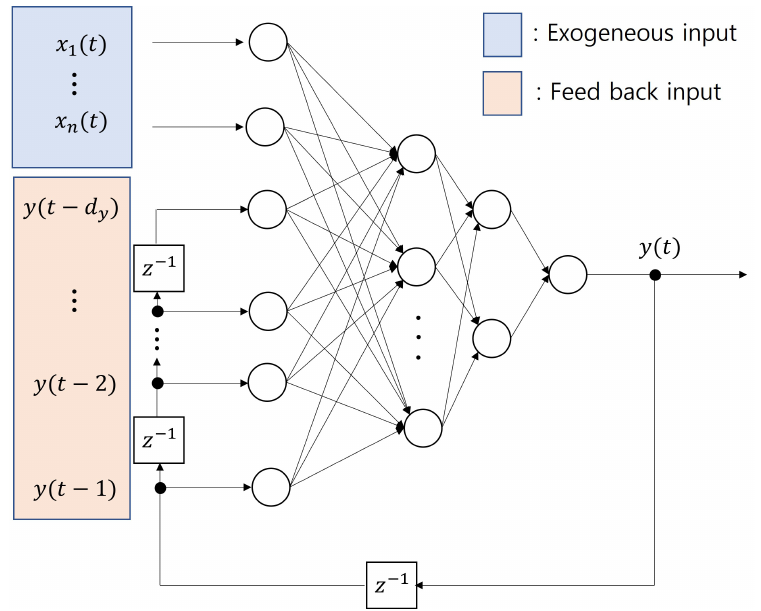
Figure 1. Non-linear auto-regressive neural network model for solar irradiation and load de- mand